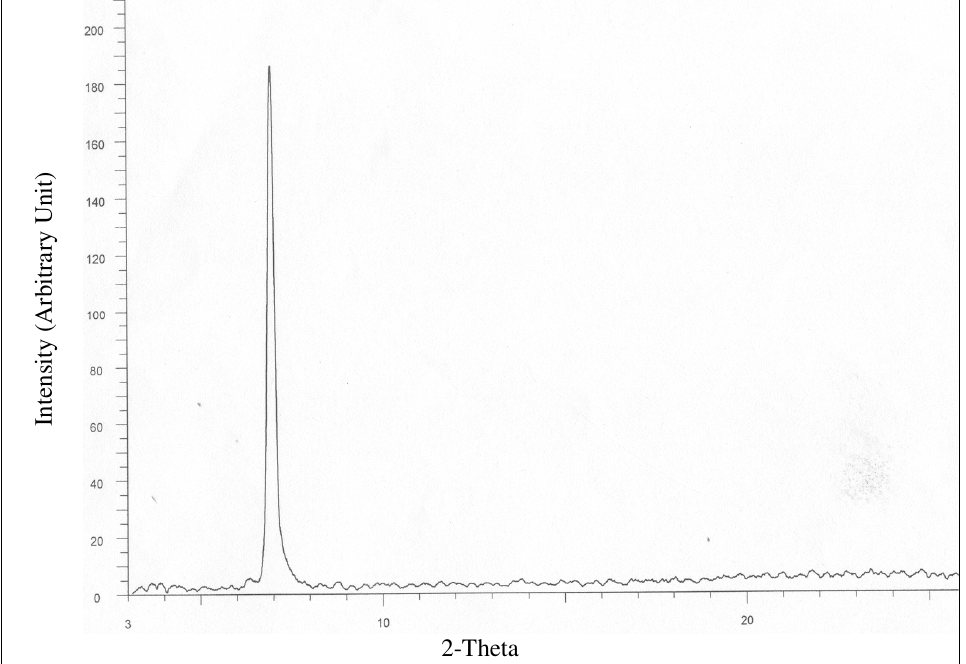
Figure 5. X-ray diffractogram of NiPc thin film prepared at substrate temperature